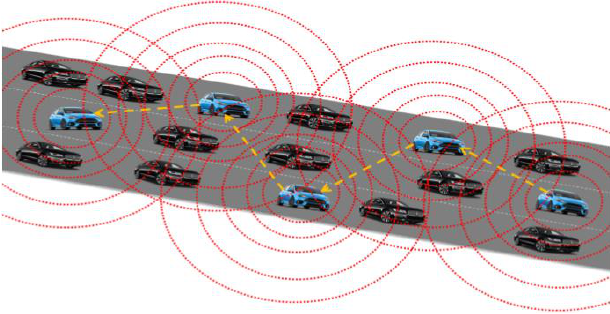
Fig. 1. Multi-hop Messages Dissemination in